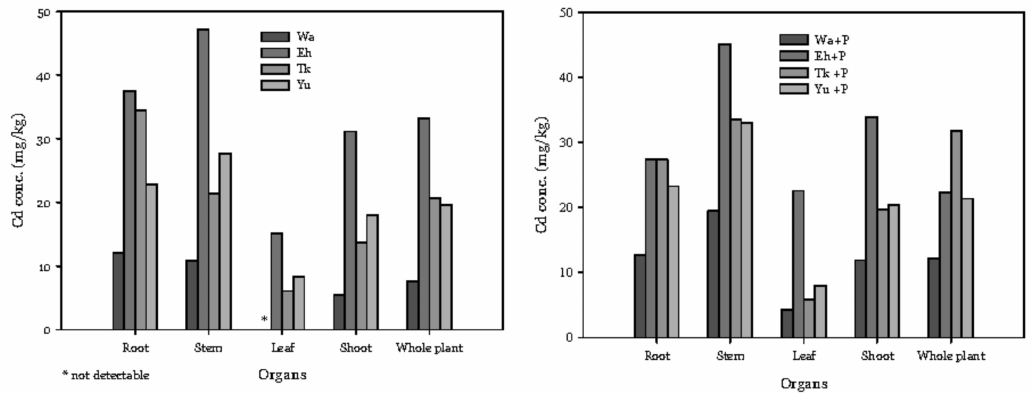
Figure 2. E ff ect of adding P on the Cd concentrations in di ff erent organs of water spinach. The meanings of the abbreviations are the same as in Table